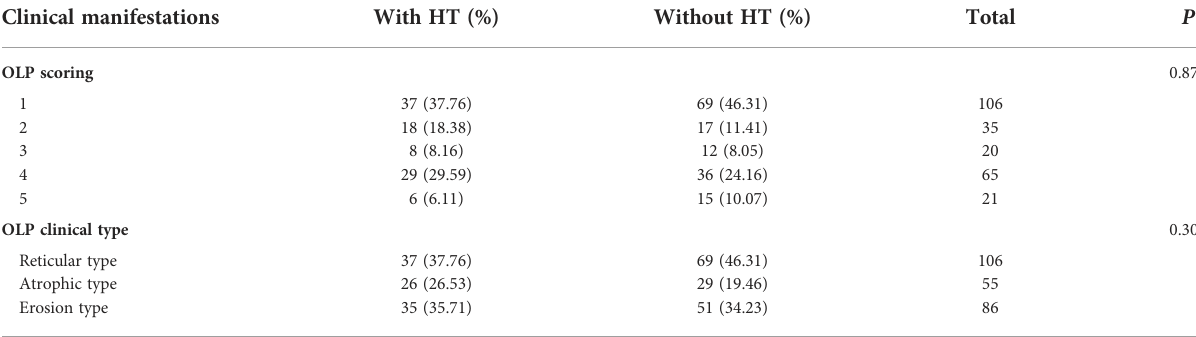
OLP, oral lichen planus; HT, Hashimoto ’ s thyroiditis. OLPscoring: 0=nolesion, normalmucosa;1= mildwhitestriaeonly, no atrophicareas; 2=whitestriaewithatrophicareas <1cm 2 ; 3=whitestriae withatrophicareas >1cm 2 ;4=white striae with erosive areas < 1 cm 2 ; and 5 = white striae with erosive areas > 1 cm 2